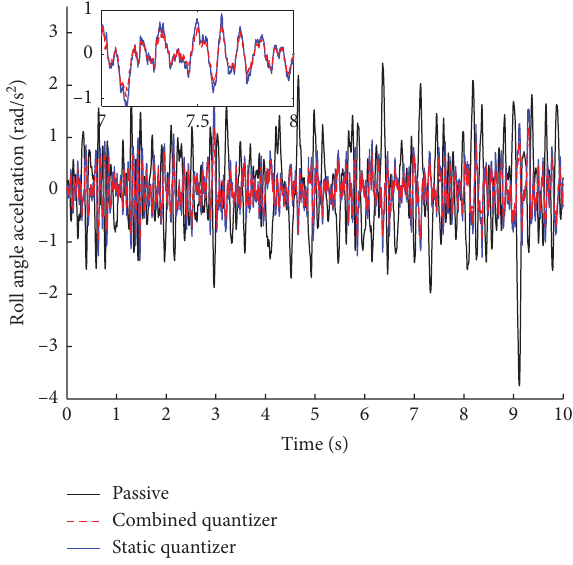
Figure 7: Sprung mass roll acceleration.